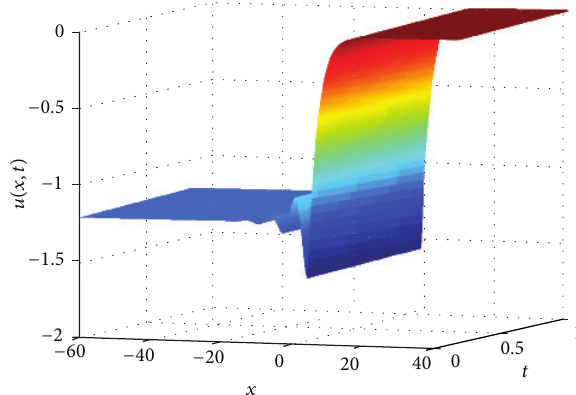
Figure 18: Plot of the approximate damped oscillatory solution (34) with 𝑎 = −0.2 , 𝑏 = 0.6 , 𝑐 = 0.2 , 𝑝 = 2 , 𝛽 = 1 , and 𝑟 = −0.5